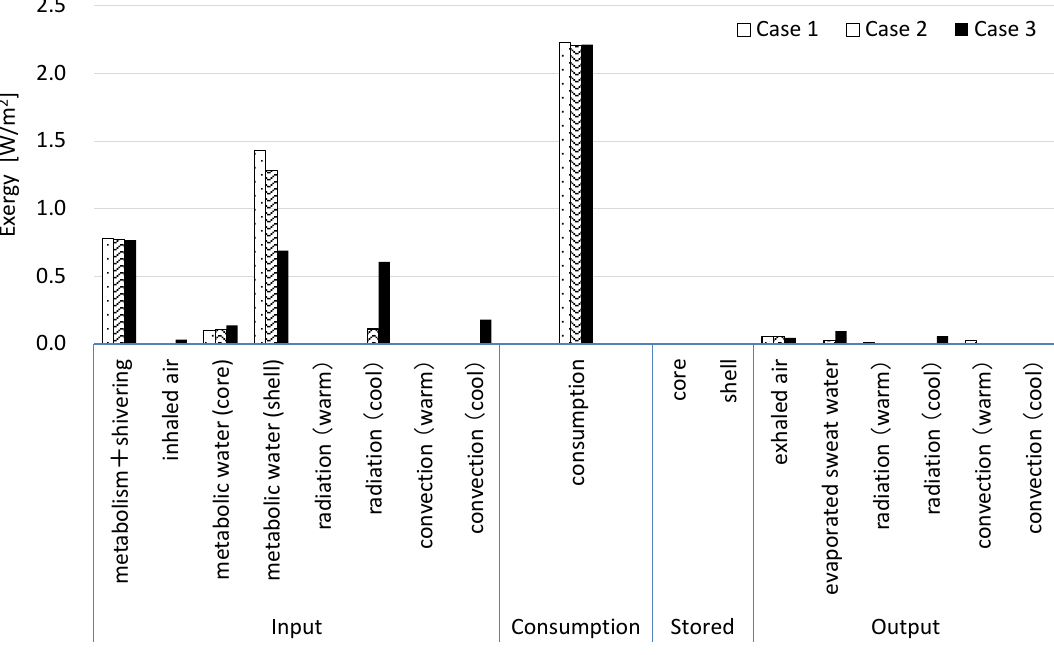
Figure 9. Elements of the human body exergy balance (August 2; 12:00 Local